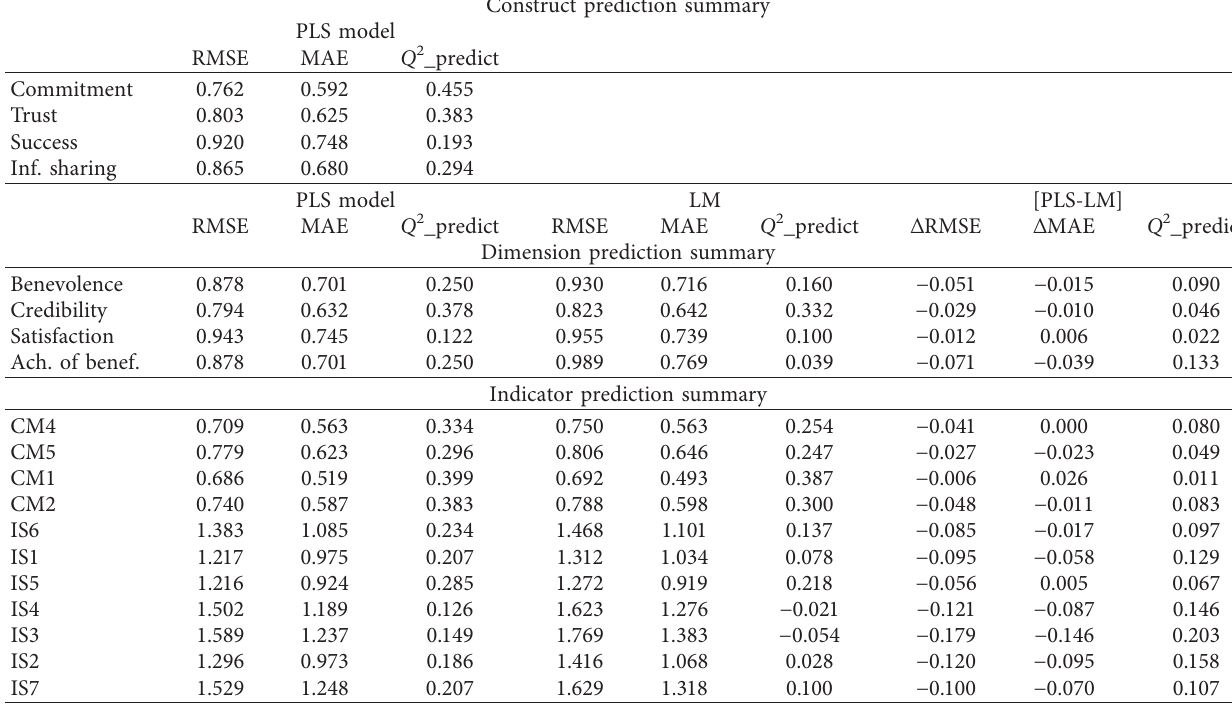
Table 14: Summary of prediction